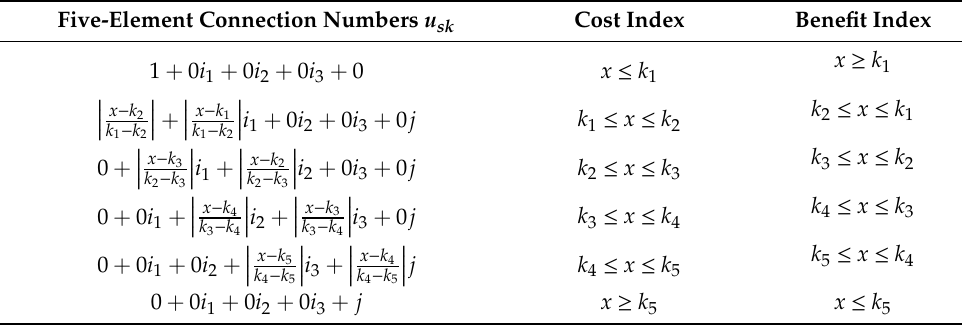
Table 3. The calculation method of five-element connection